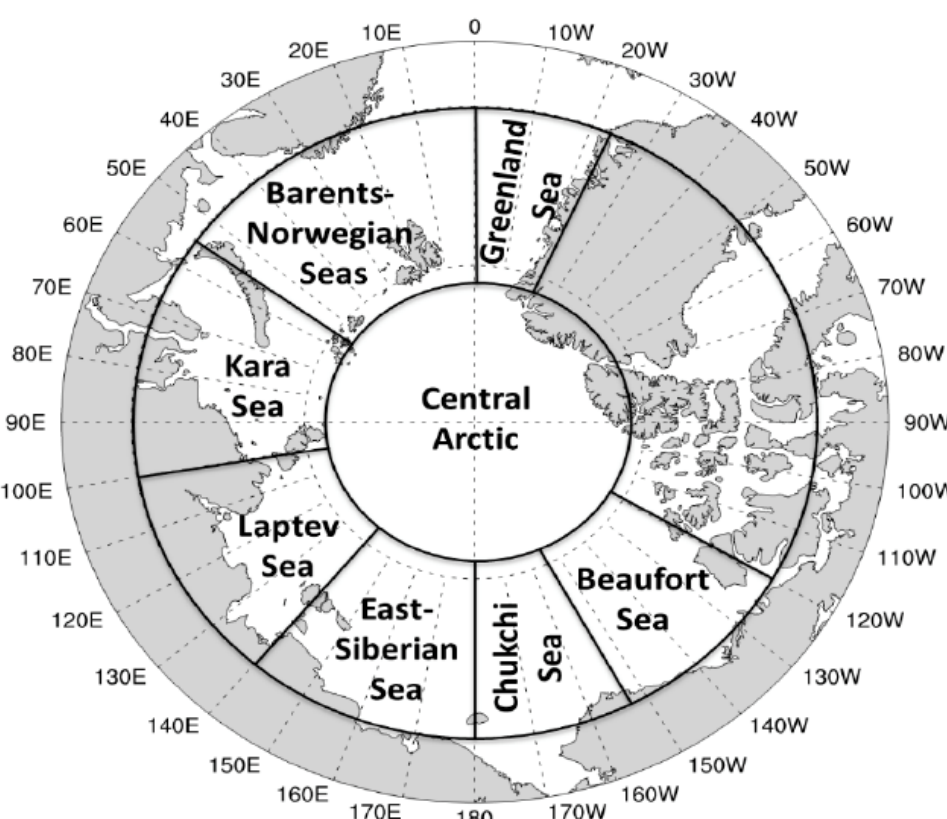
Figure 1. Division of the Arctic subregions the storm activity analysis in this study, including the Barents–Norwegian Seas (BN), Greenland Sea (GS), Kara Sea (KS), Laptev Sea (LS), East Siberian Sea (ESS), Chukchi Sea (CS), Beaufort Sea (BS), and Central Arctic (CA).